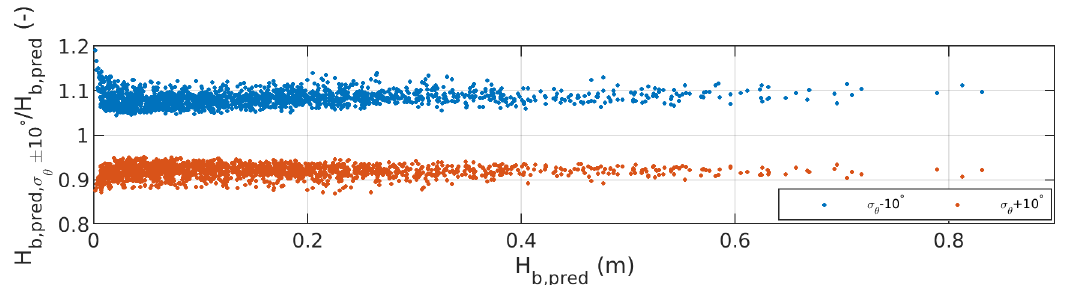
Figure 7. Predicted bound wave height H b , pred , σ decreased (blue: − 10 o ) directional spreading over the original bound wave height prediction H b , pred as a function of H b , pred for all